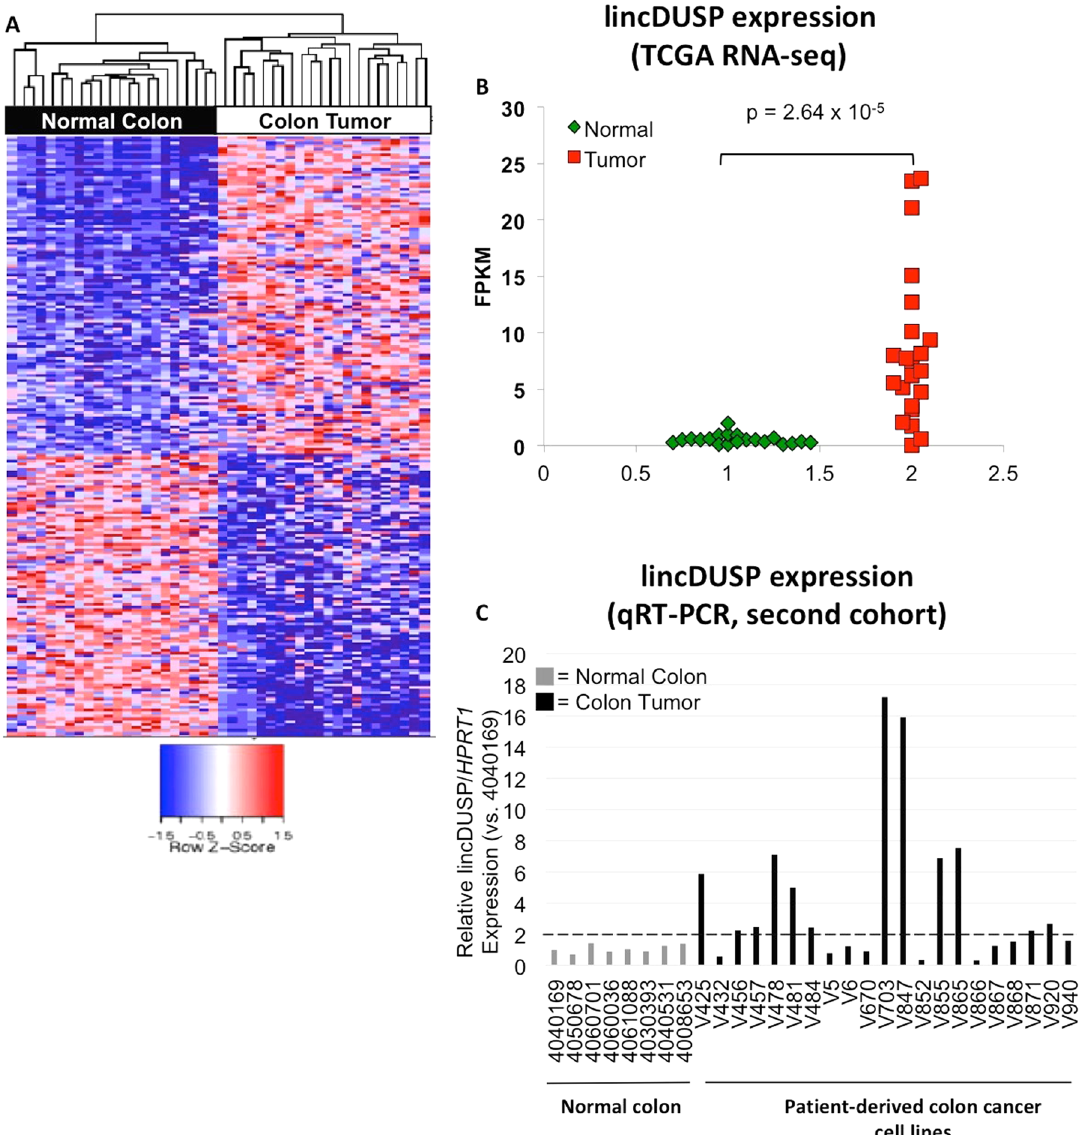
Figure 1. lincDUSP is a candidate oncogenic lncRNA that is overexpressed in a subset of colon tumors. ( A ) Heatmap of differentially expressed lncRNAs ( > 2-fold change, p < 0.05) identified from 22 colon tumors and 22 matched normal colon tissue from TCGA RNA-Seq data. ( B ) Cluster graph of lincDUSP FPKM values from tumors vs. normal colon from TCGA RNA-Seq data. ( C ) Taqman qRT-PCR for lincDUSP in an independent cohort of patient-derived normal colon and colon tumor samples. Values were normalized to the normal colon sample ID number 4040169, and HPRT1 was used an endogenous